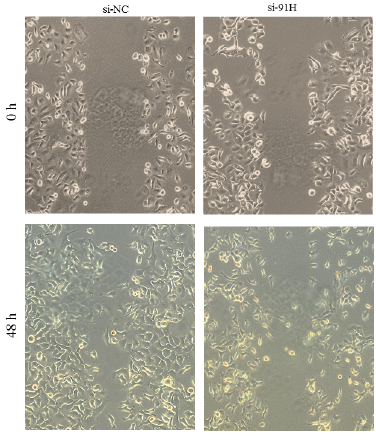
Figure 11. The scratch wound assay was assessed to cell motility. The knockdown of 91H inhibited HCT-116 cell